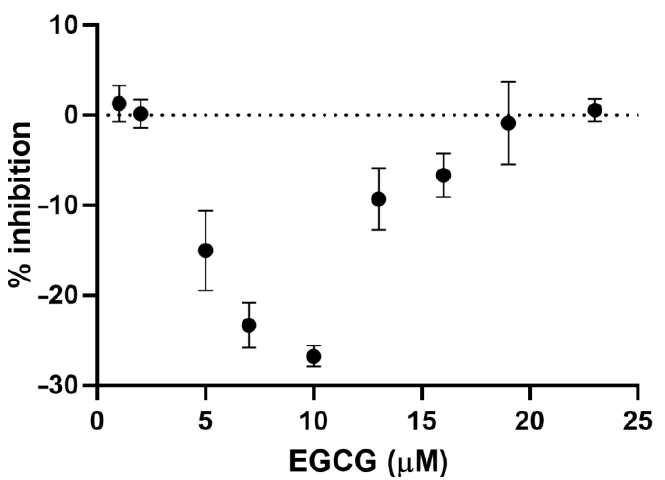
Figure 5. Percentage of inhibition as a function of the EGCG concentration measured in the system Fe(II)/Quin.